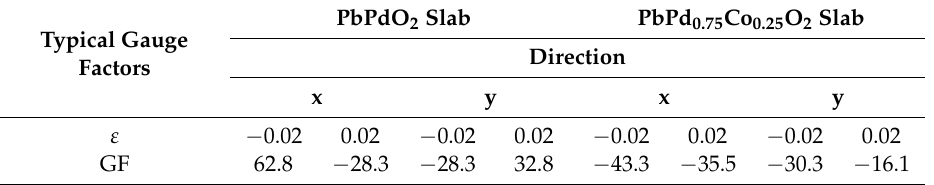
Figure 11. The piezoresistive gauge factor as a function of strain for ( a ) PbPdO 2 , and ( b ) PbPd 0.75 Co 0.25 O 2 along the x and y axes. Table 1. Some typical gauge factors of PbPdO 2 and PbPd 0.75 Co 0.25 O 2 along the x and y axes.